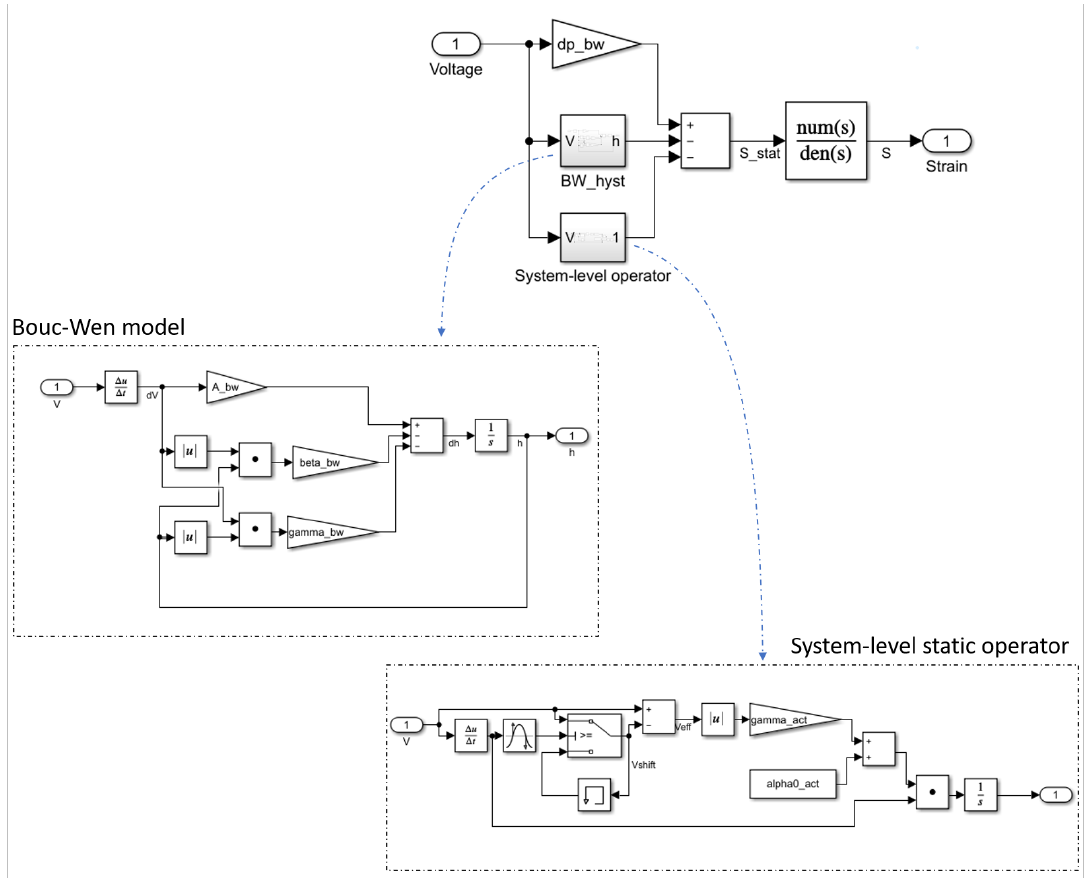
Figure 13. Considered model of the piezoelectric actuator for the control